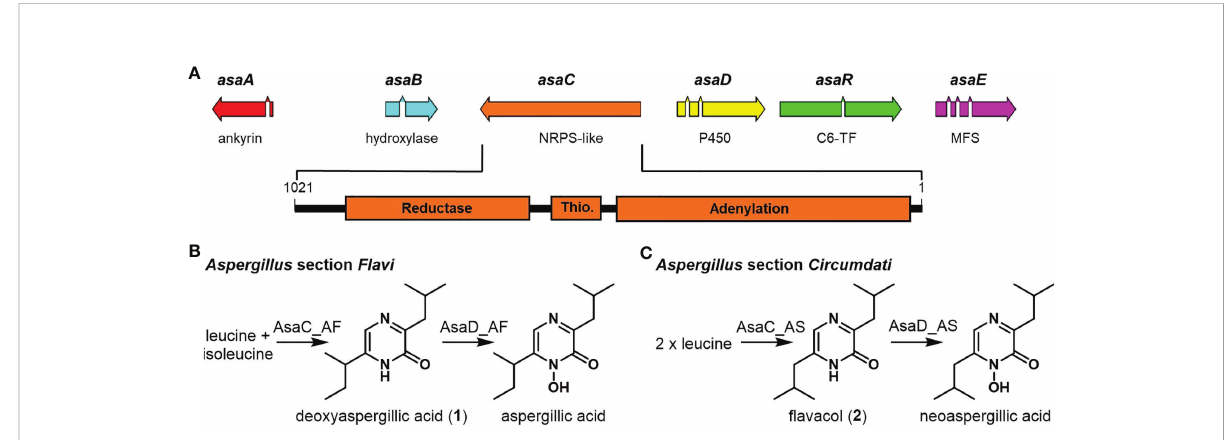
FIGURE 1 The pyrazinone precursors to aspergillic acids are formed by the NRPS-like enzyme AsaC in Aspergillus spp. (A) Schematic of the asa biosynthetic gene cluster responsible for aspergillic acid production contains the NRPS-like core gene asaC , which is comprised of Adenylation- Thiolation-Reductase (ATR) domains. Introns are shown as gaps in the genes. (B) Species in Aspergillus section Flavi such as A. fl avus produce aspergillic acid from leucine and isoleucine through a deoxyaspergillic acid ( 1 ) intermediate. (C) Species in Aspergillus section Circumdati such as A. sclerotiorum produce neoaspergillic acid from two leucine residues from a fl avacol ( 2 )